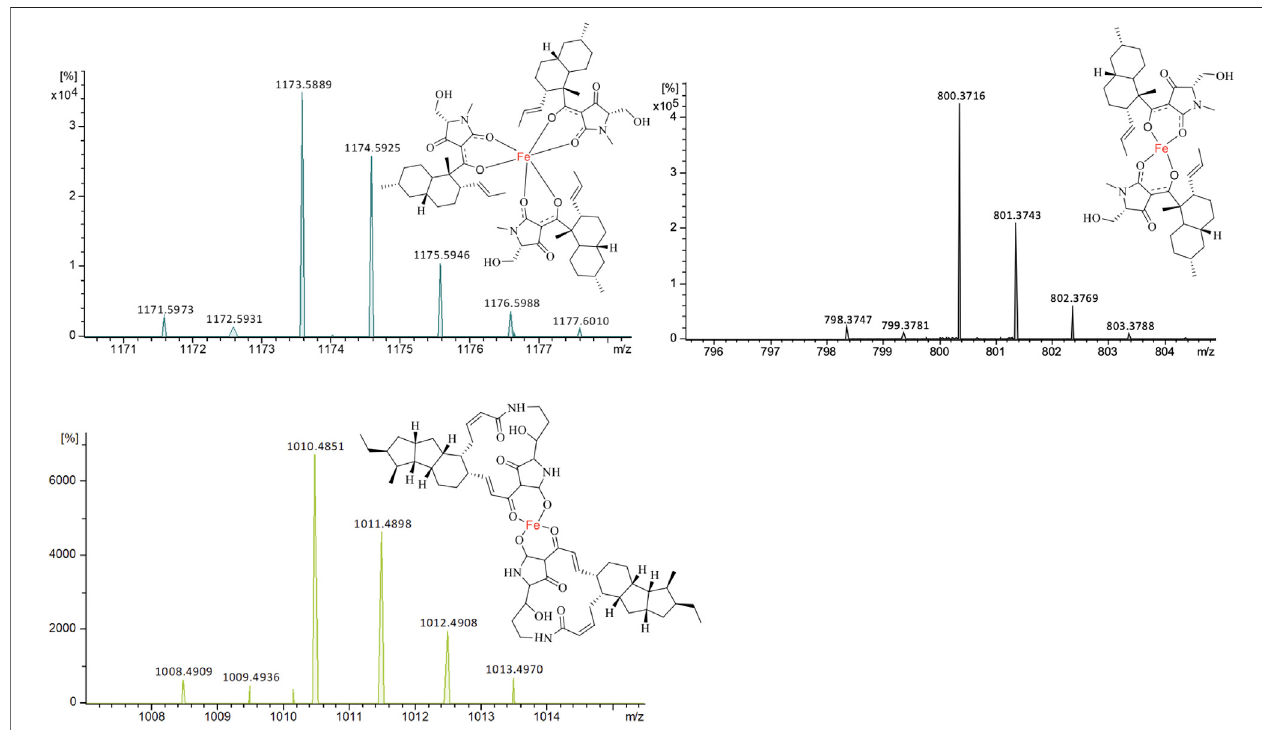
FIGURE 3 | ESIMS for the two different stoichiometries of equisetin-Fe(III) complexes and one ikarugamycin-Fe(III) complex. (A) [M + H] + , m/z 1,171.5993, Fe(III)(equisetin) 3 ; (B) [M + H] + , m/z 798.3747, Fe(III)(equisetin) 2. (C) [M + H] + , m/z 1,008.4909, Fe(III)(ikarugamycin) 2